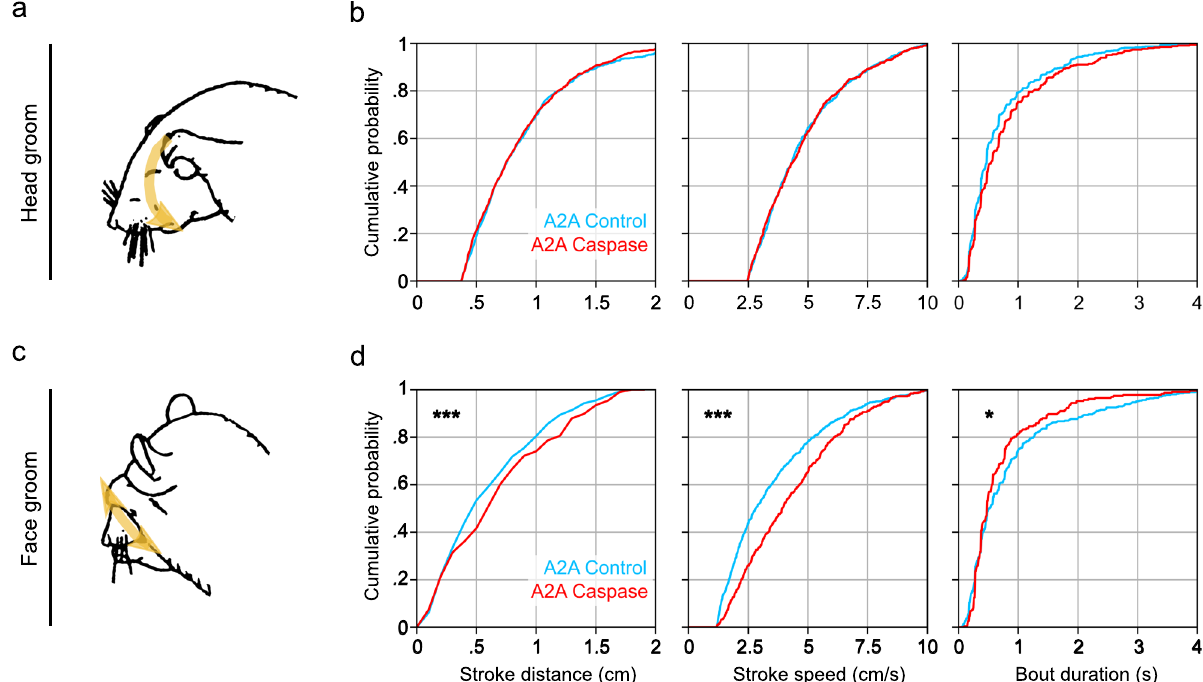
Fig. 6 Detection of robust, hard to detect kinematic changes in grooming behavior following cell-type speci fi c lesion. a Schematic of canonical head grooming and (bottom) face. b Cumulative histograms of distances and speed of the individual strokes comprising a bout, and of bout duration (control - blue; lesioned - red, N = 4 animals, one session each). * p < 0.05, *** p < 0.0001, two-tailed Kolmogorov-Smirnov test). ( c , d ) Same as ( a , b ), but for canonical face grooming. Source data are provided as a Source Data fi le for ( a